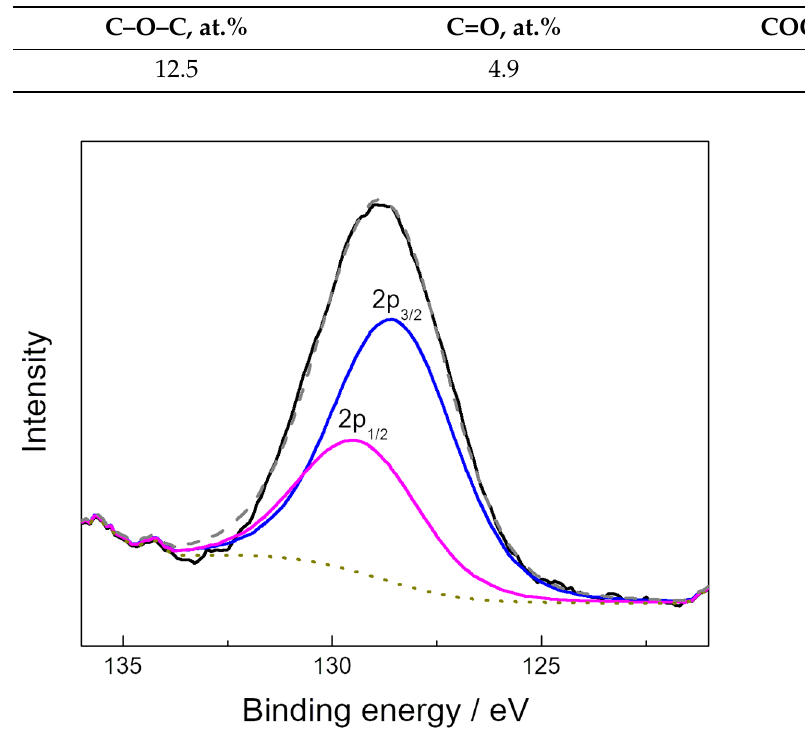
Figure 4. P 2p high-resolution spectrum of the graphene-phosphorene